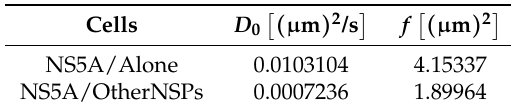
Table A6. Fit parameters in (A1) of linear regression dependency of diffusion constant value on pseudo reaction constant on 2D planar geometry.